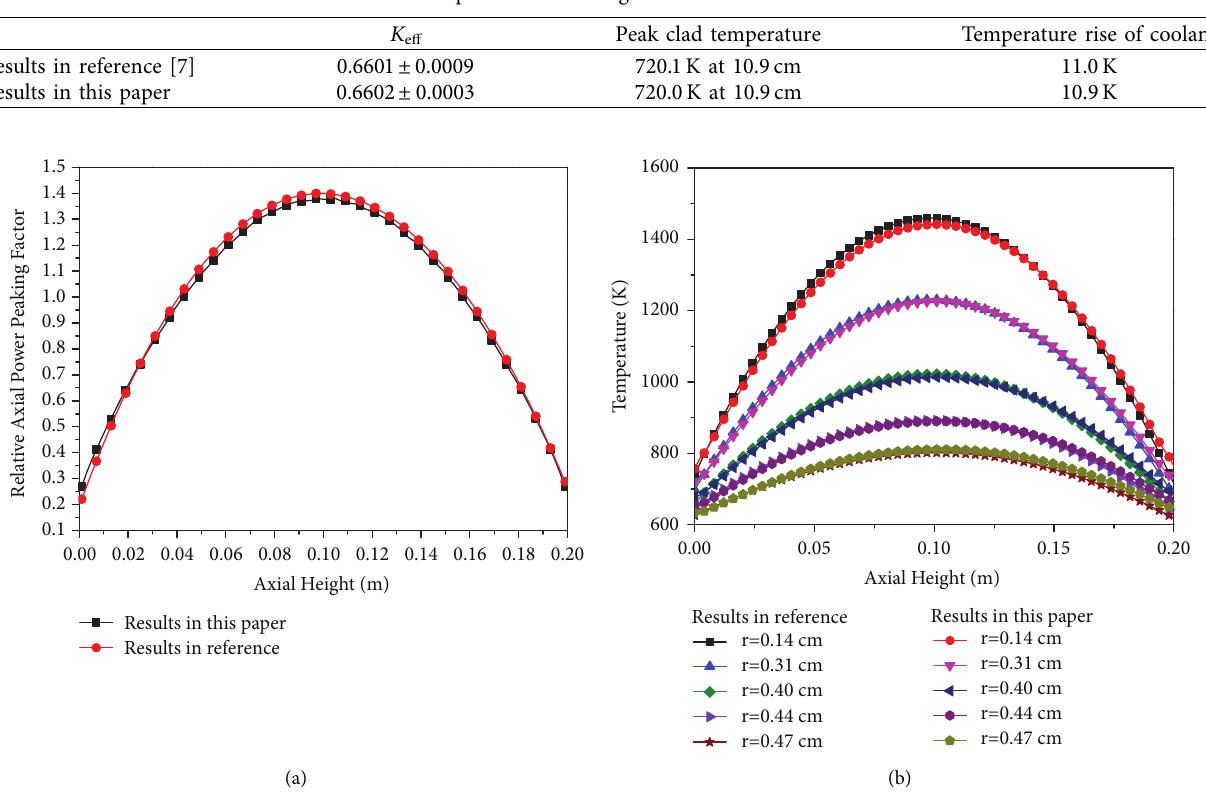
Figure 9: Comparison of (a) the relative axial power distribution and (b) the axial fuel temperature distribution at different radial